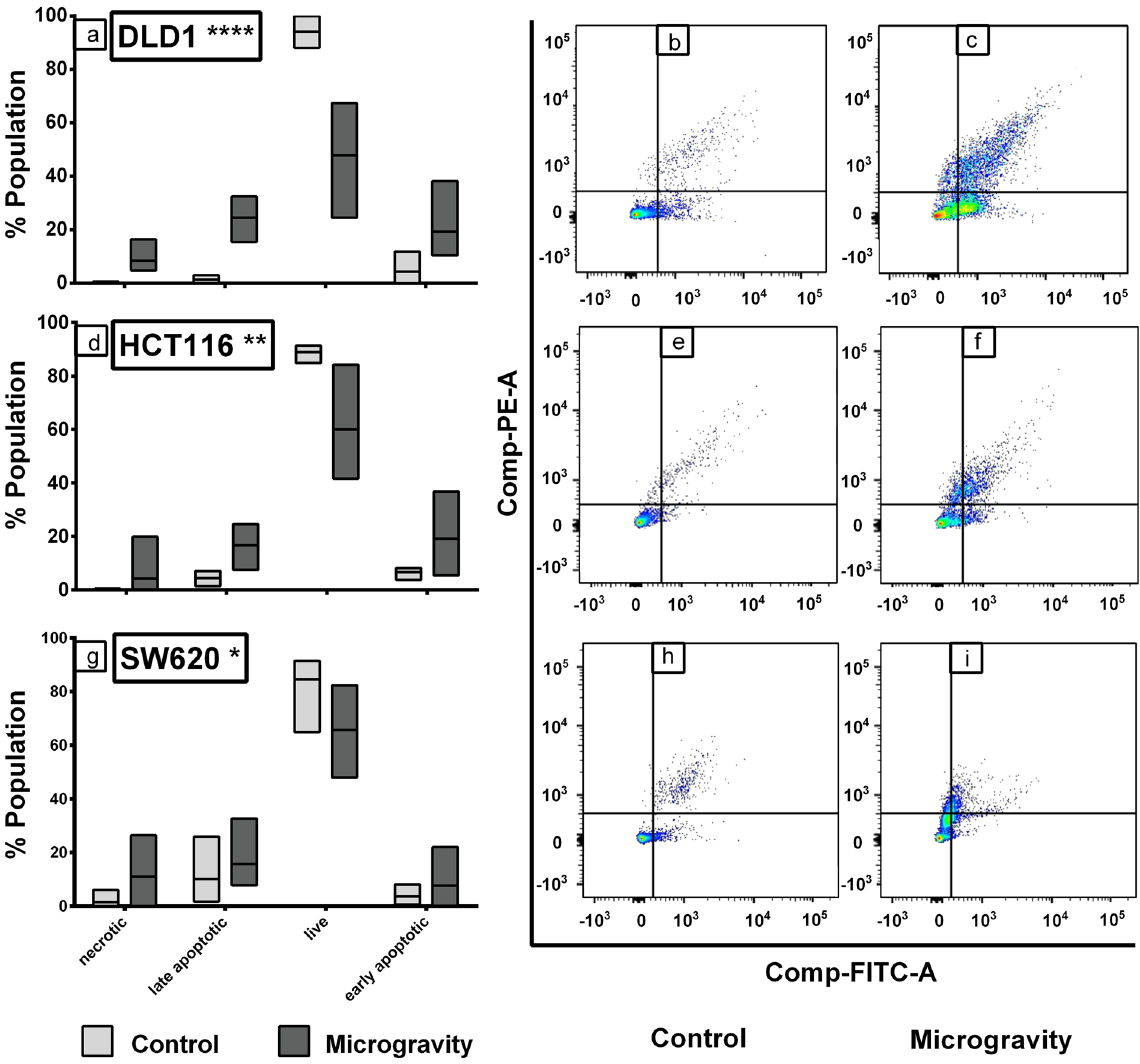
Figure 3. Cell death in microgravity is majorly through apoptosis. The box plot for the AnnexinV FITC & PI staining for DLD1 ( a ), HCT116 ( d ) and SW620 ( g ) shows that major cell death during SM is induced through apoptosis. The lighter boxes represent control populations and darker ones represent SM cell populations. The data is represented as mean with data range. **** P < 0.0001, ** P < 0.005, * P < 0.05 statistical analysis using two way annova. The dot plot clearly shows the cells are Annexin V FITC and PI positive cells under SM for all cell lines tested ( c , f , i ) compared to control cells ( b , e , h